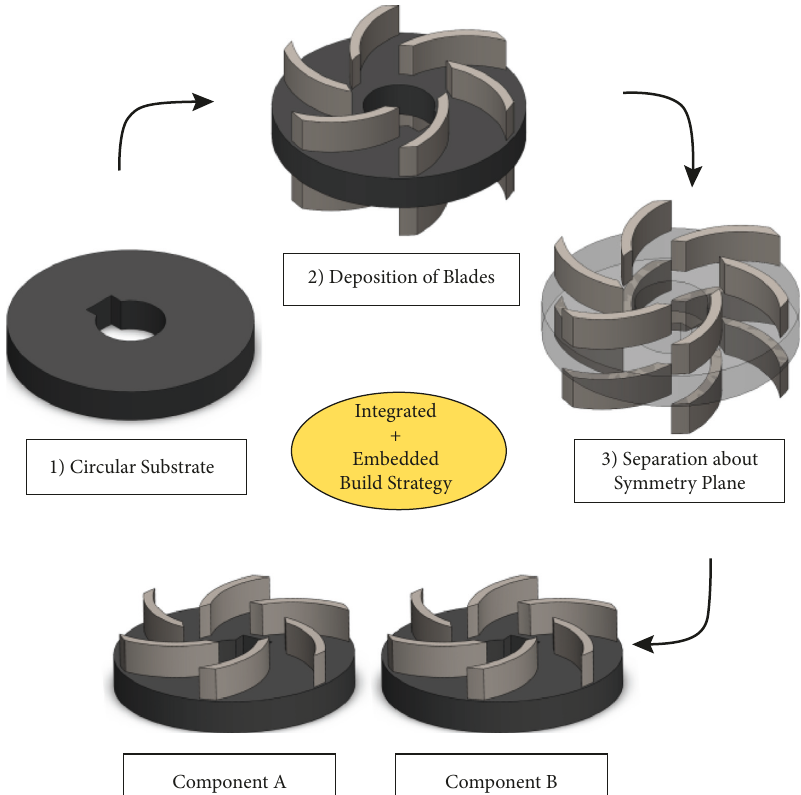
Figure 30: Hybridization of integrated and embedded build strategy.